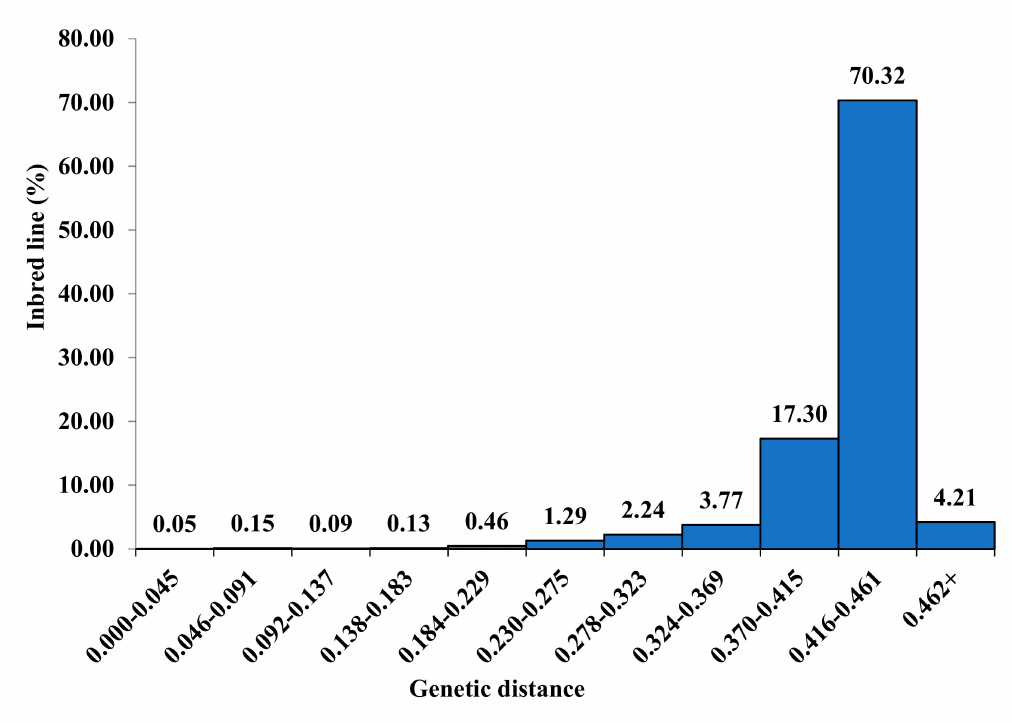
Figure 3. Frequency distribution of genetic distances based on Euclidean method for 162 early yellow and white inbred lines genotyped using 9864 DArT